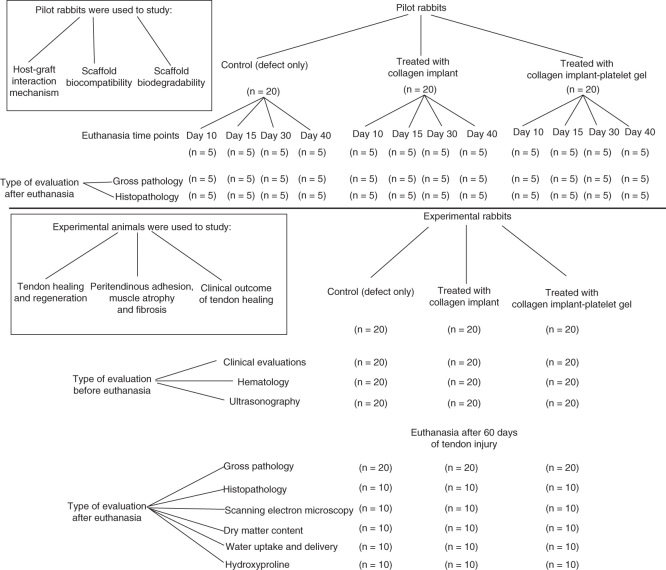

Schematic description of grouping details and evaluation methods.